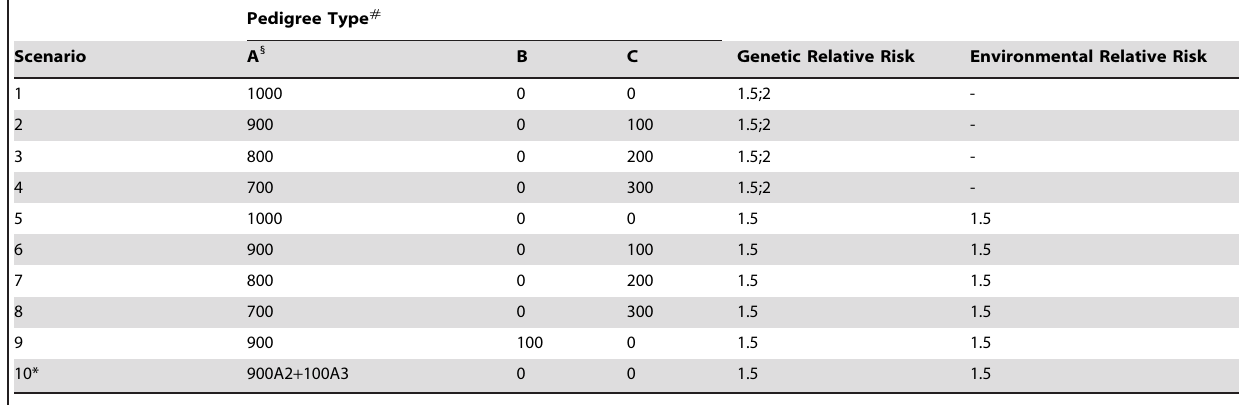
Table 1. Parameter settings of the 10